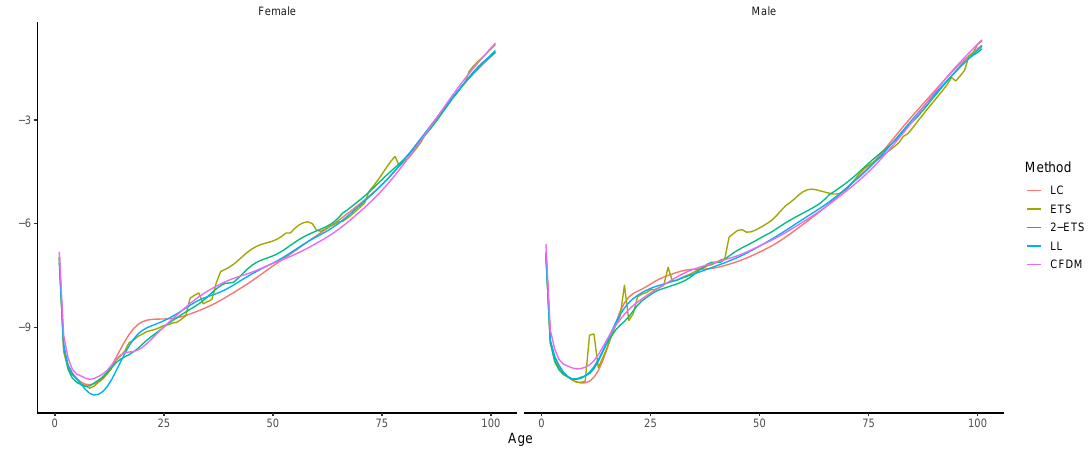
Figure 8. Predicted log mortality rates for Australia in